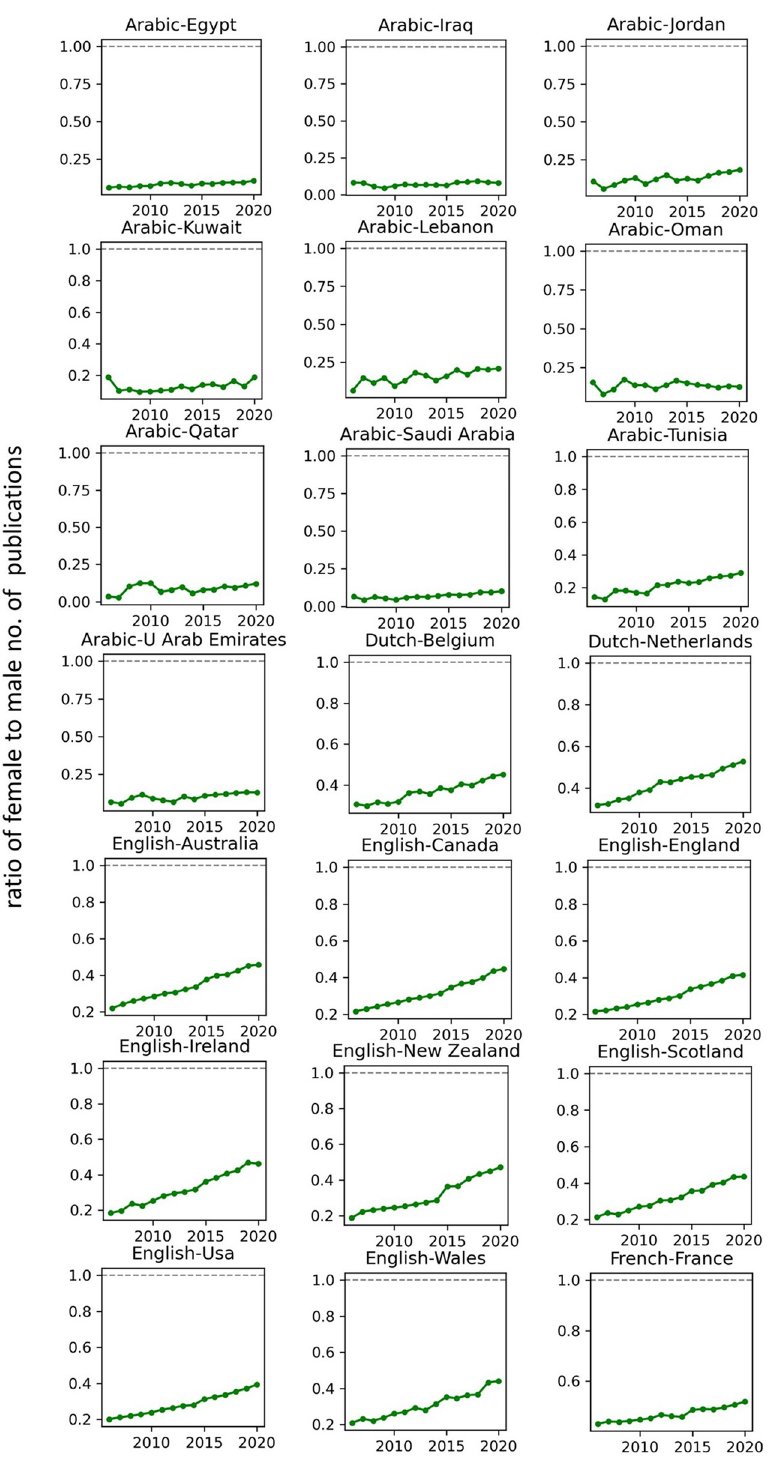
Fig 19. Ratio of female to male total research productivity, based on A-Z method (part 1).